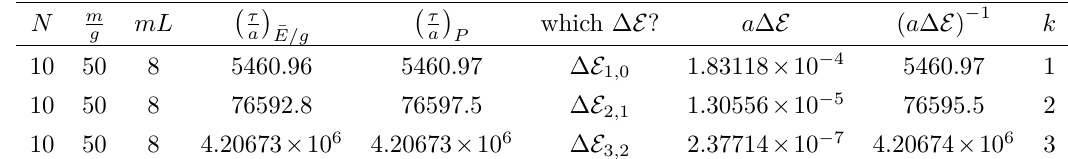
Table 1. The timescale τ/a and the relevant energy splittings ∆ E for different types of quenched tunneling in the large mL regime as shown in figures 2, 3, 4. The timescales (cid:0) τ are extracted from lattice data of the electric field (cid:10) ¯ E (cid:11) /g and the quantum mechanical probability using fits (3.1) and (3.2) respectively. ∆ E